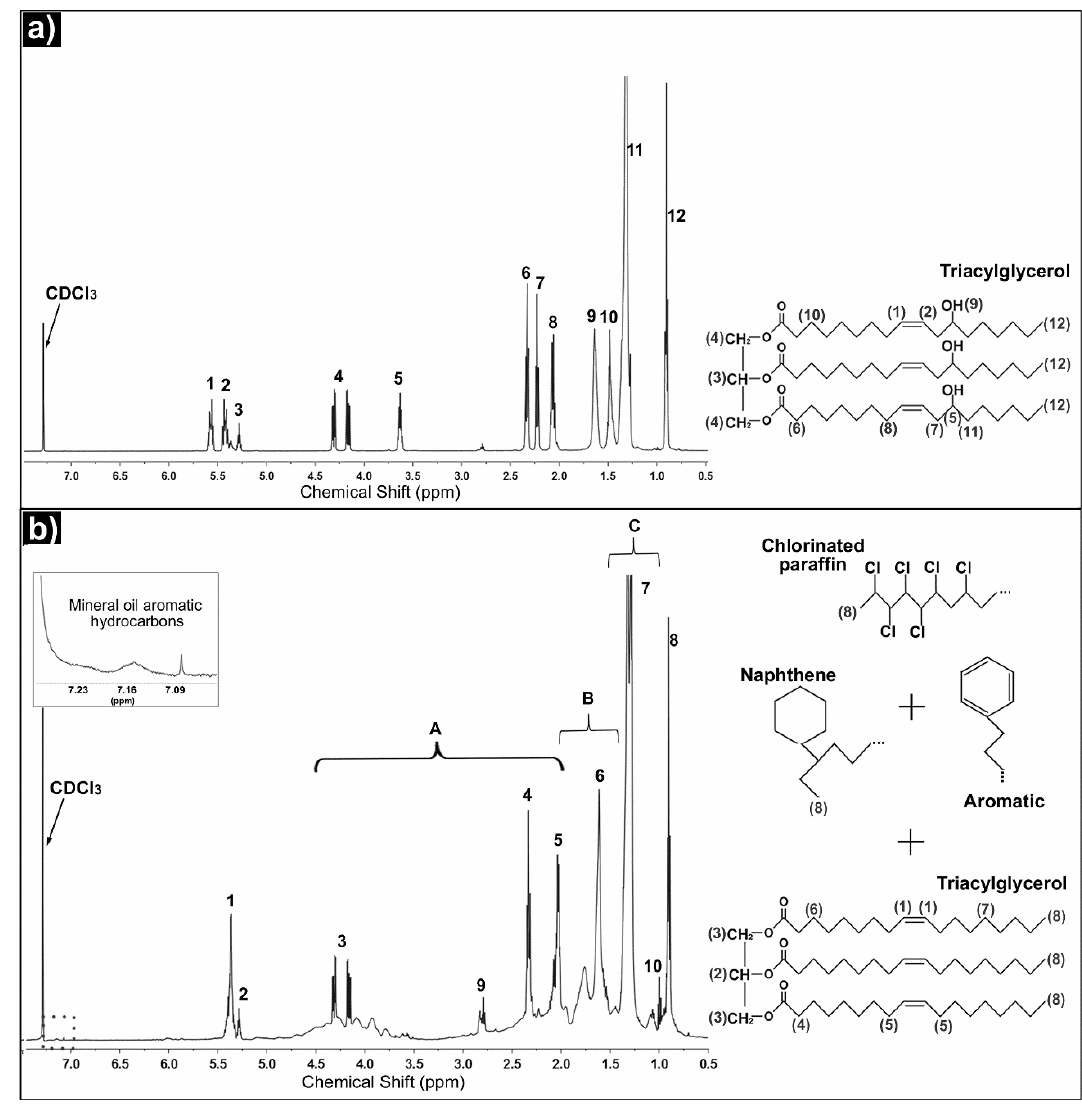
Figure 3. 1 H-NMR spectra of Castor ( a ) and Reference ( b ) oil in CDCl 3 at 500 MHz.